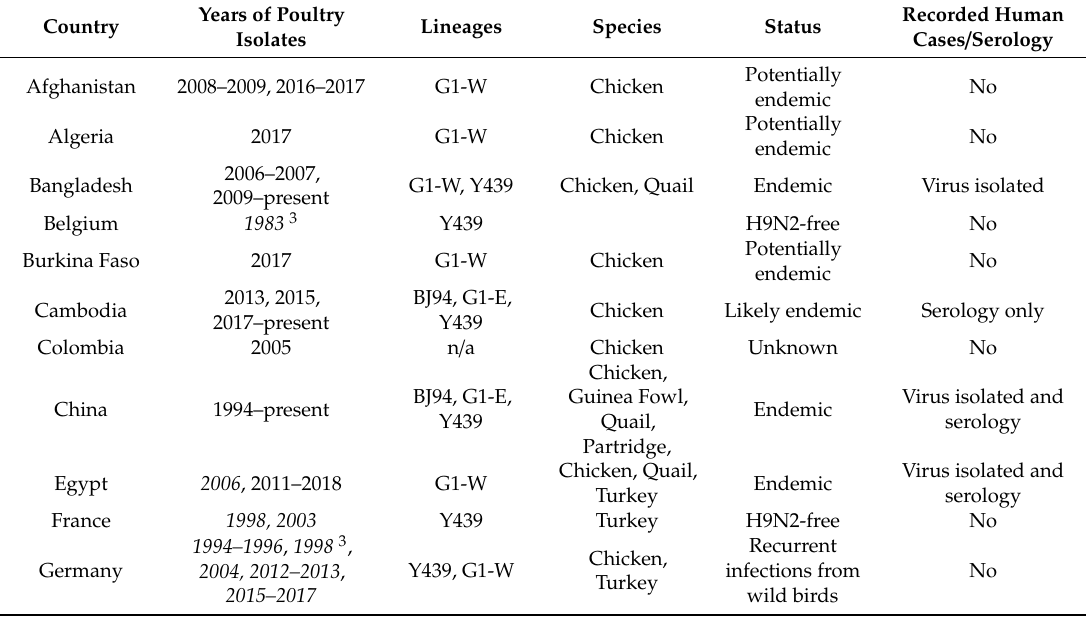
Table 1. List of countries with laboratory confirmed H9 infections in domestic gallinaceous